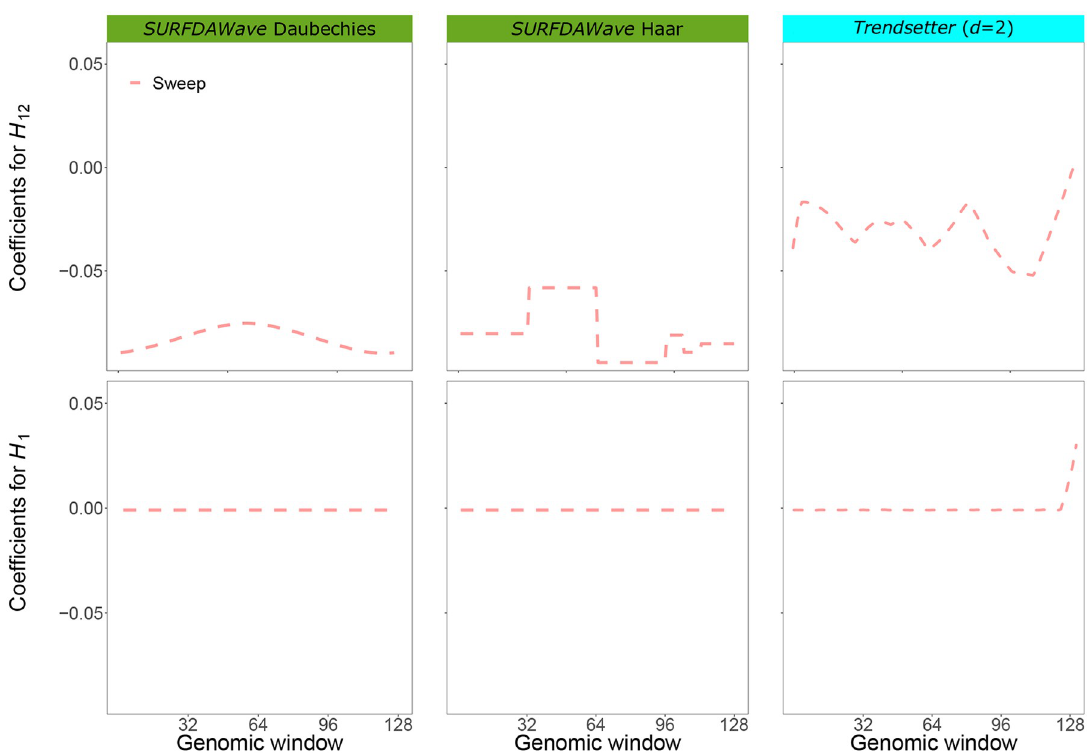
Fig 3. Reconstructed wavelets from regression coefficients ( β s) in sweep versus neutrality scenarios for summary statistics H 1 and H 12 for SURFDAWave and Trendsetter when both methods were trained on simulations of scenarios simulated under demographic specifications for European CEU demographic history. Note that the wavelet reconstructions for all summary statistics are plotted on the same scale, thereby making the distributions of some summaries difficult to decipher as their magnitudes are relatively small. SURFDAWave results compare the use of Daubechies’ least-asymmetric to Haar wavelets to estimate spatial distributions of summary statistics. Summary statistics ^ p , H 1 , H 12 , H 2 / H 1 , and frequency of the first, second, third, fourth, and fifth most common haplotypes used by both Trendsetter and SURFDAWave . Level and γ chosen through cross validation for SURFDAWave (see Training the models ).